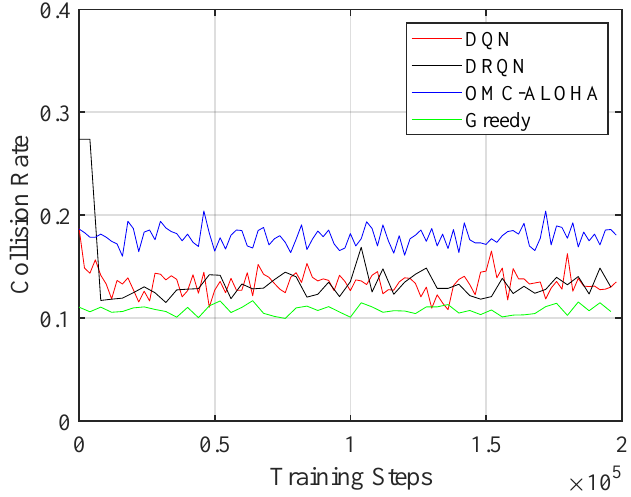
Figure 4. The collision rate of the proposed method with different training steps (single SU).